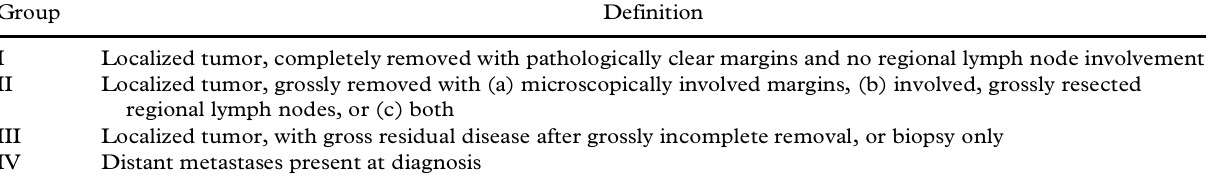
Table 1. IRSG surgical± pathologic grouping